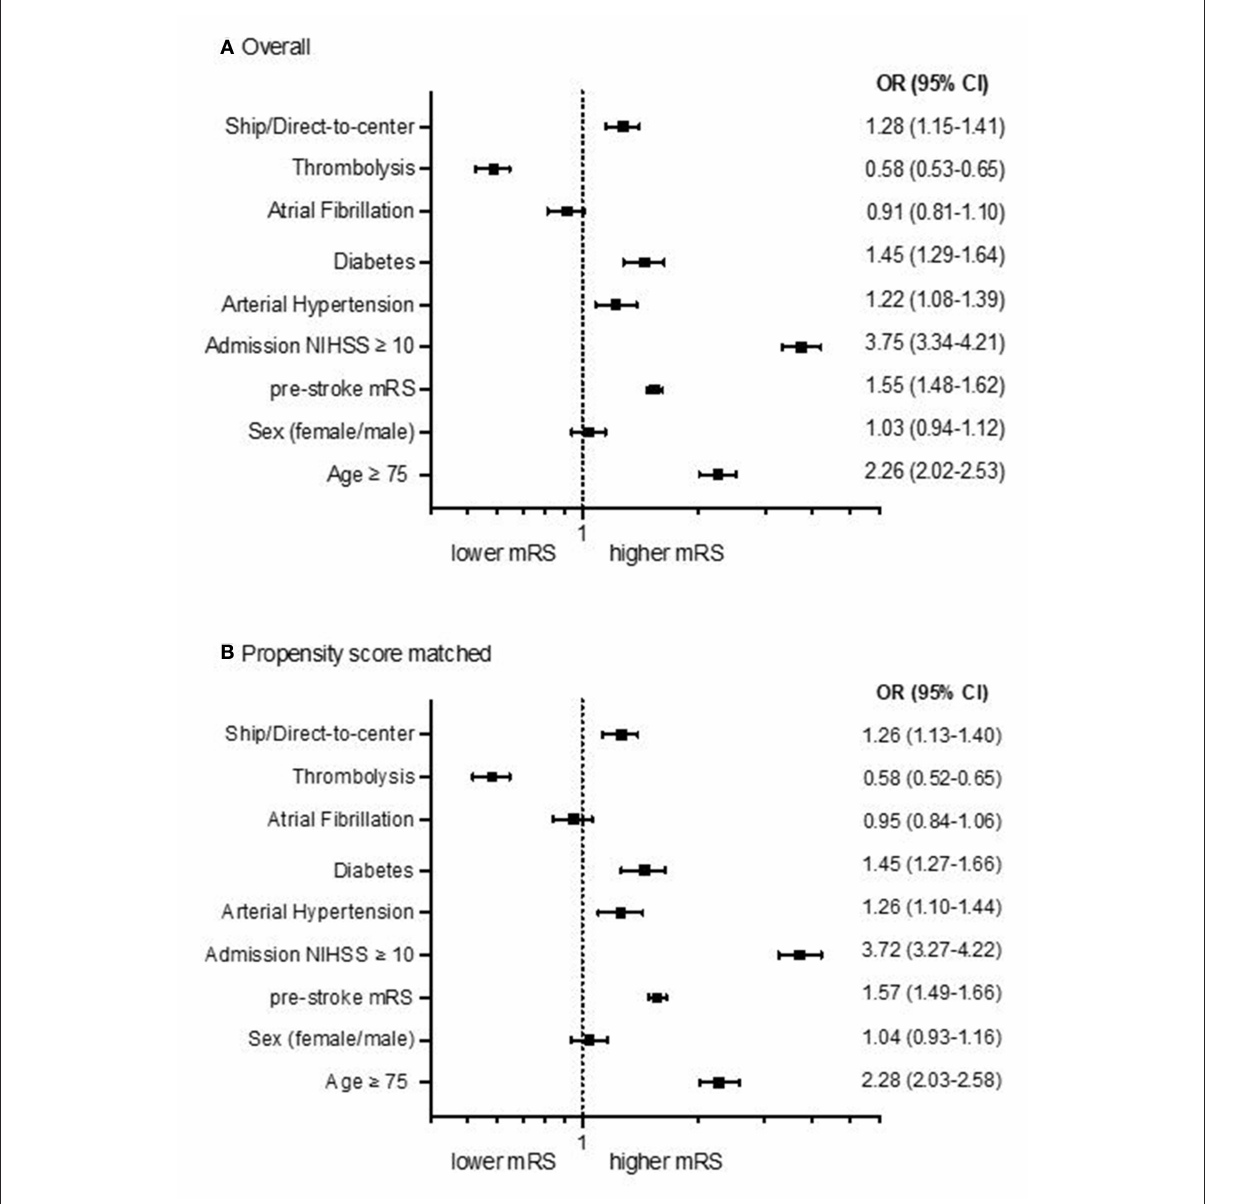
FIGURE1 Forest plots showing multivariable ordinal regression analyses of the adjusted common odds ratio (OR) of modified Ranking Scales (mRS) 90 days after stroke for DC/DS admission status, sex, age, admission NIHSS, comorbidities and thrombolysis in all patients [ (A) , n = 5,107] and after propensity score matching [ (B) , n = 4,348]. The OR is presented logarithmically with 95%-confidence